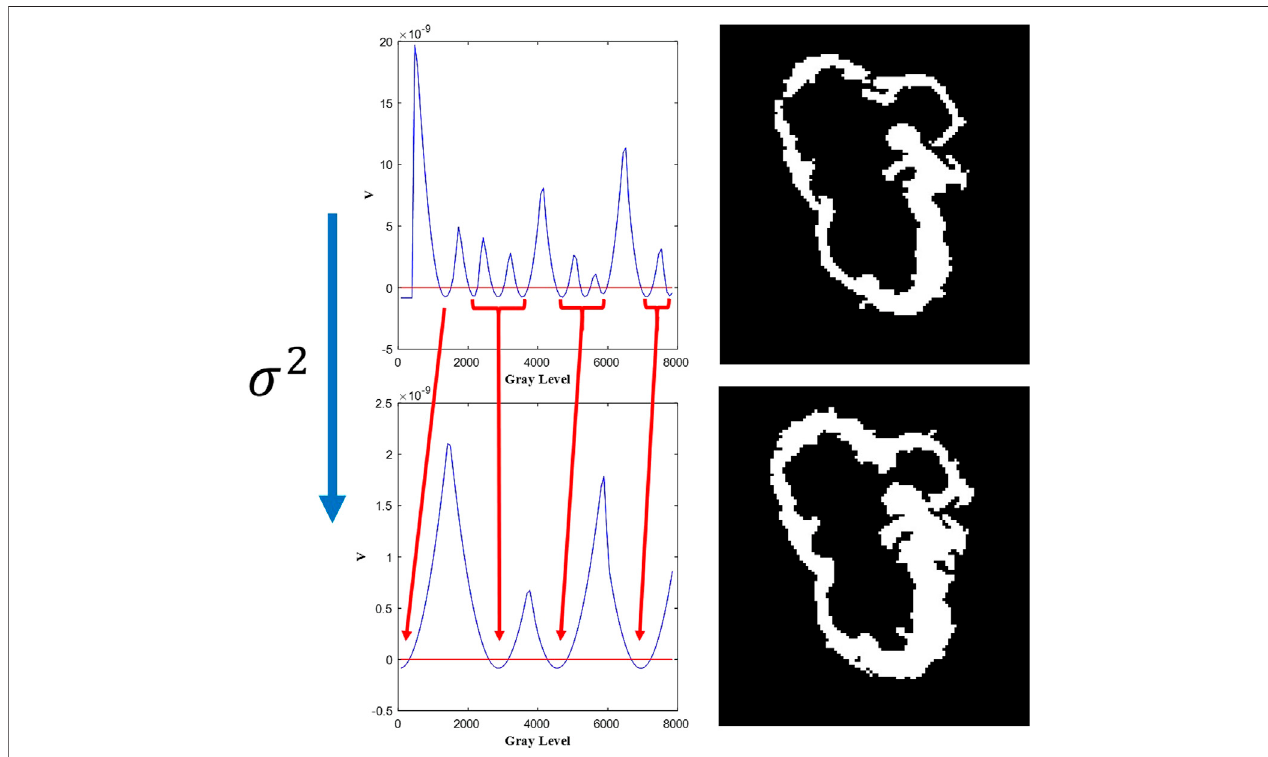
FIGURE2| Dependenceofthesegmentationprocedureonthevalueofthe ‘ mass ’ oftheparticle, σ 2 .Arrowsindicatehowthepotentialenergyminima,inthe ‘ trap ’ potential, collapse as σ 2 is increased from top to bottom by a 3-fold factor. On the right, the corresponding segmentation.